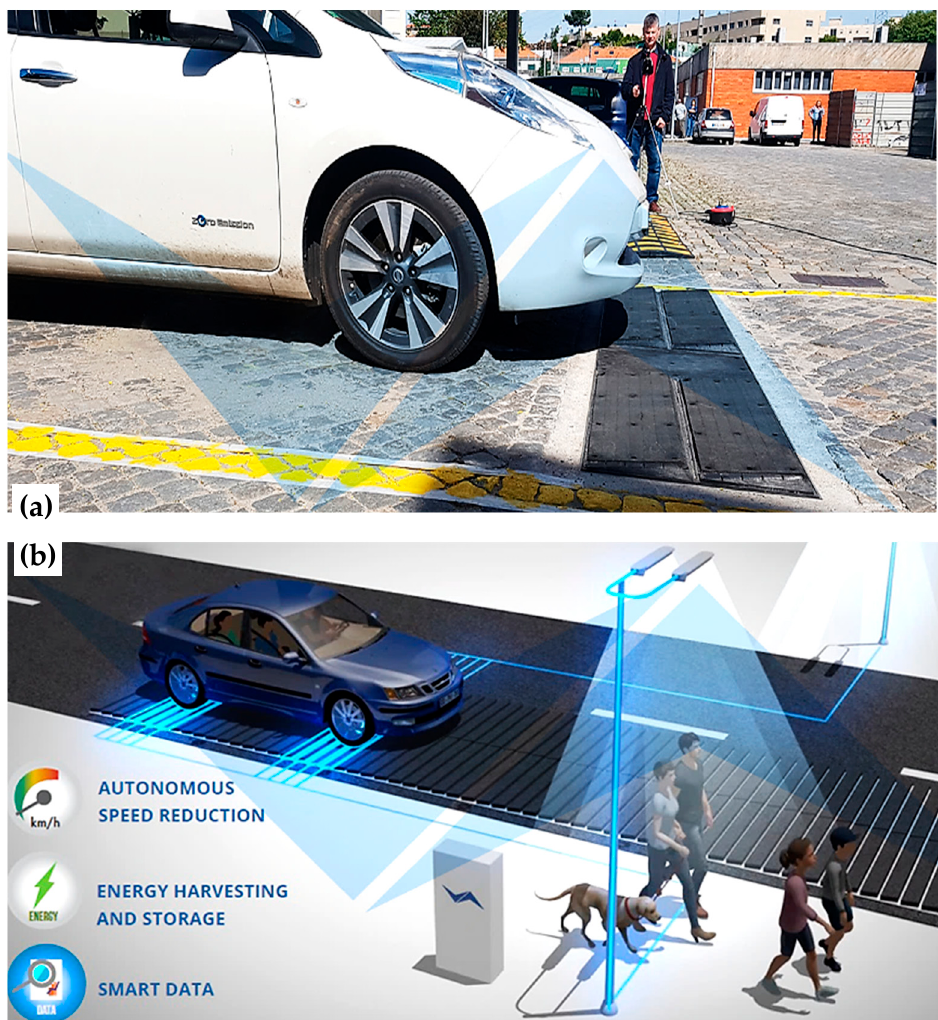
Figure 18. ( a ) Prototype of NEXT-road by Pavnext: the beta prototype was developed and tested in the years 2018-2020 allowing the company to reach TRL6; ( b ) First pilot plant in production by Pavnext Co. which will be implemented in the City of Matosinhos (Portugal) (Reprinted with permission from Ref. [122]. Pavnext Co. Porto, Portugal) [122].